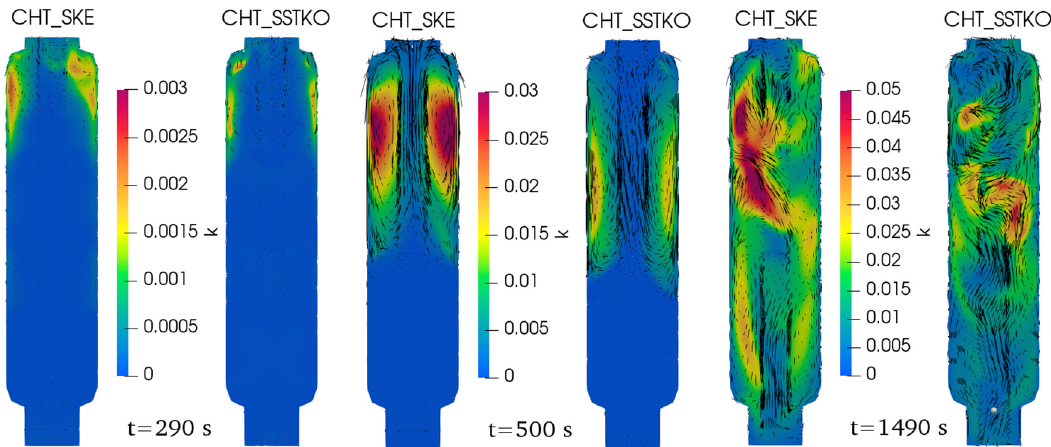
Figure 11. Comparison of the contour plot of the predicted turbulent kinetic energy, k (m 2 / s 2 ), by means of different turbulence models.